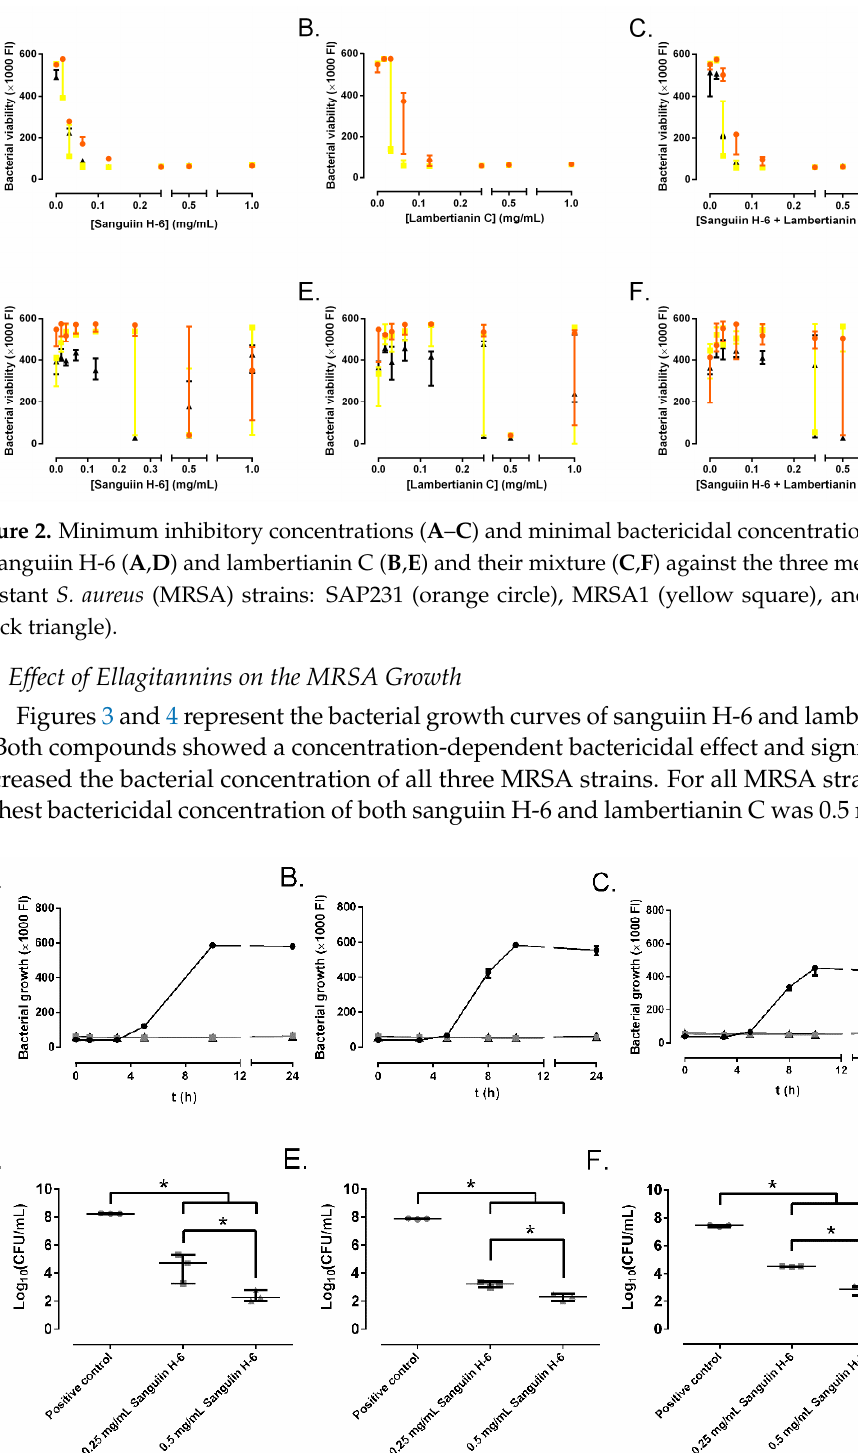
Figure 4. The effect of different concentrations of lambertianin C on SAP231 ( A , D ), MRSA 1 ( B , E ), and MRSA 2 ( C , F ) growth: control (circle), 0.25 mg/mL (square), and 0.5 mg/mL (triangle) over time ( A – C ) and at 24 h ( D – F ). *: p- value < 0.05 for Wilcoxon test. 2.3. Effect on Biofilm Development Sanguiin H-6 and lambertianin C showed a significant concentration-dependent inhibitory effect on MRSA biofilm development (Figure 5). Sanguiin H-6 decreased the biofilm growth between 85.1% and 91.1% at 0.25 mg/mL, and between 90.7% and 92.4%